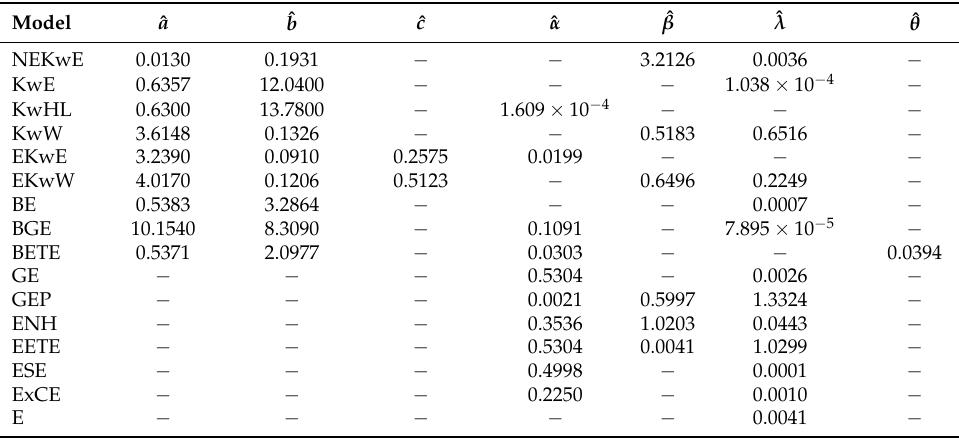
Table 8. MLEs of the parameters of the considered models for the second data set.